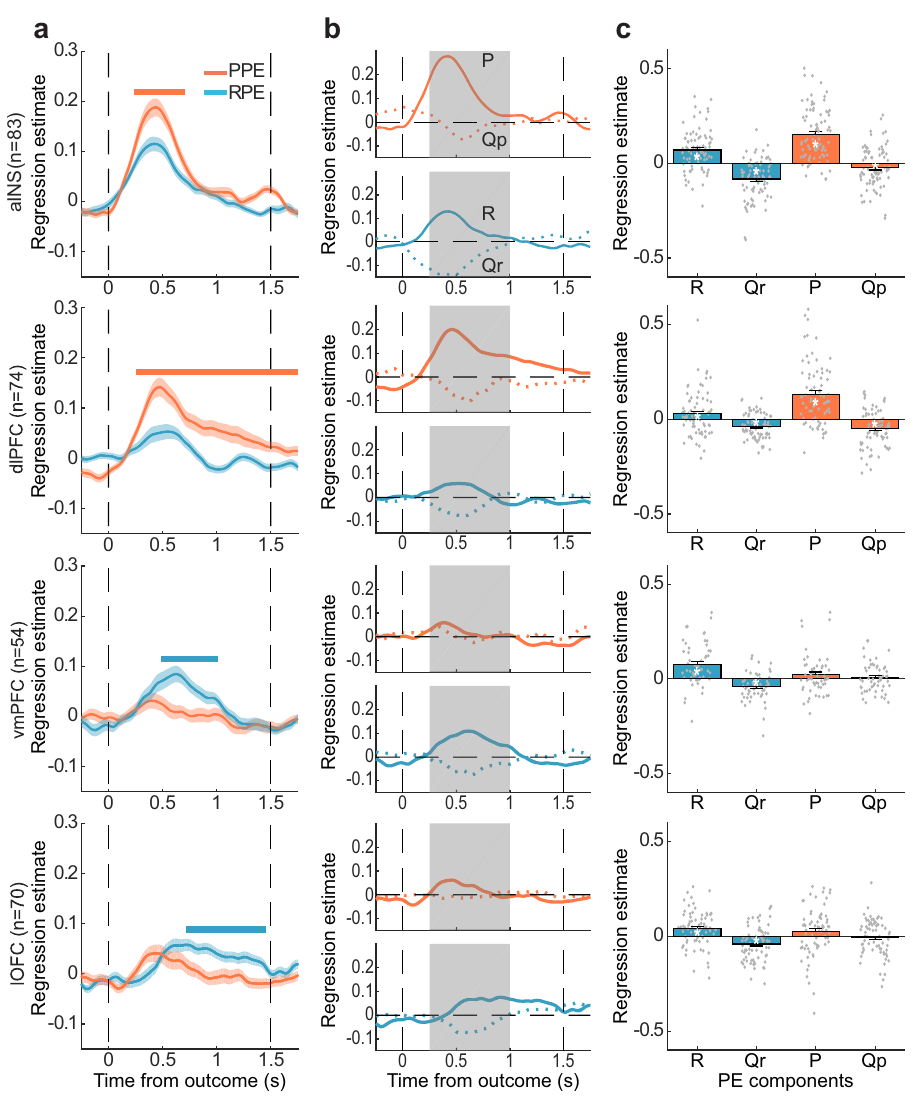
Qp PE componentsTime from outcome (s)Time from outcome (s) Fig. 4 Dissociation of reward PE (R-Qr) and punishment PE (P-Qp) signals. a Time course of regression estimates obtained from linear fi t of BGA with PE modeled separately for the reward (blue) and punishment (red) conditions (PPE punishment prediction error, RPE reward prediction error). Horizontal bold lines indicate signi fi cant difference between conditions (blue: RPE > PPE; red: PPE > RPE; pc < 0.05). Shaded areas represent inter-sites SEM. b Time course of regression estimates obtained from a linear model including both outcome (solid lines) and expected value (dotted lines) components for both reward (R and Qr) and punishment (P and Qp) PE. c Regression estimates averaged over the 0.25 – 1 s time window (represented as shaded gray areas in panels b ). Stars indicate signi fi cance (* p < 0.05, one-sample, two-tailed Student ’ s t test). Error-bars correspond to inter-sites SEM and dots correspond to individual recording sites. The sample size ( n ) used to derive statistics in all panels was: aINS: n = 83 sites; dlPFC: n = 74; vmPFC: n = 54; lOFC: n =